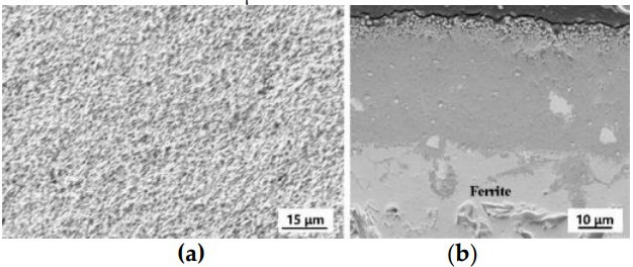
Figure 4. SEM images of MnZn ferrite immersed in molten salt for 20 min: ( a ) surface section; ( b ) cross-section.